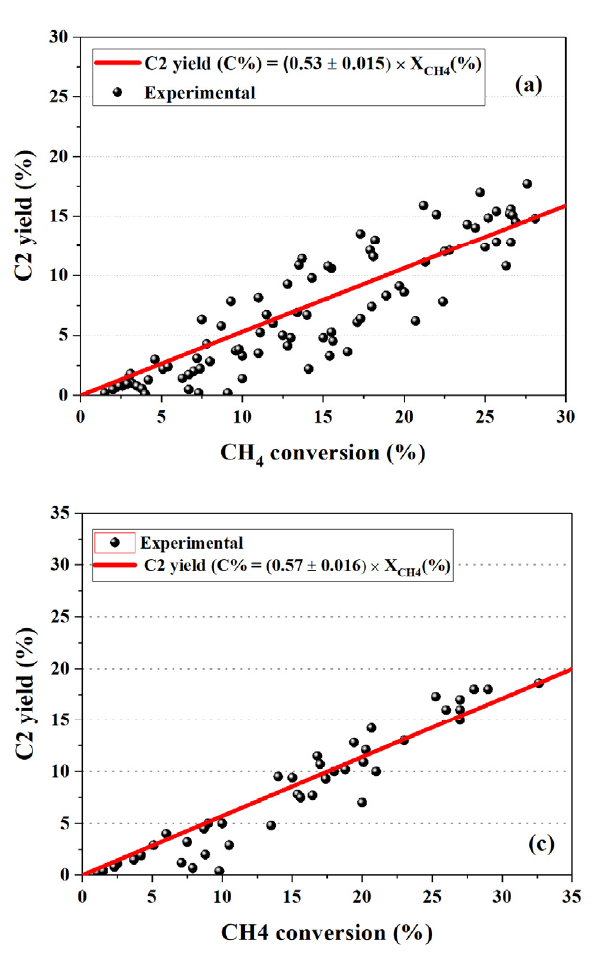
Figure 32. Experimental C2 yields as a function of CH 4 conversion for bimetallic oxides: ( a ) promoted or supported alkaline earth metal oxides, ( b ) involving lanthanoids metal oxides, and ( c ) transition or post-transition metal oxides. Data sources are indicated in the text.